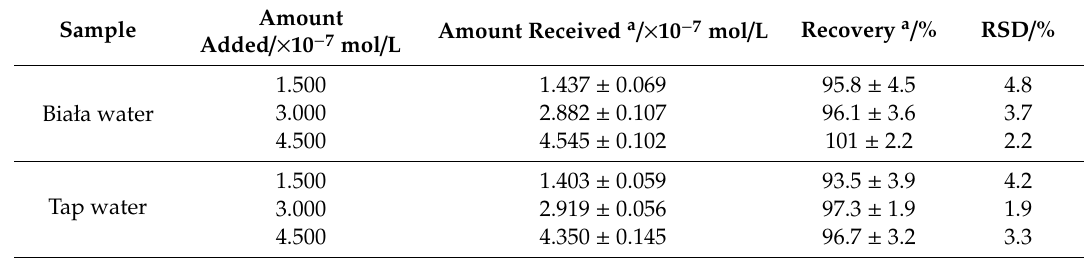
Table 3. Results of itraconazole determination in spiked water samples.